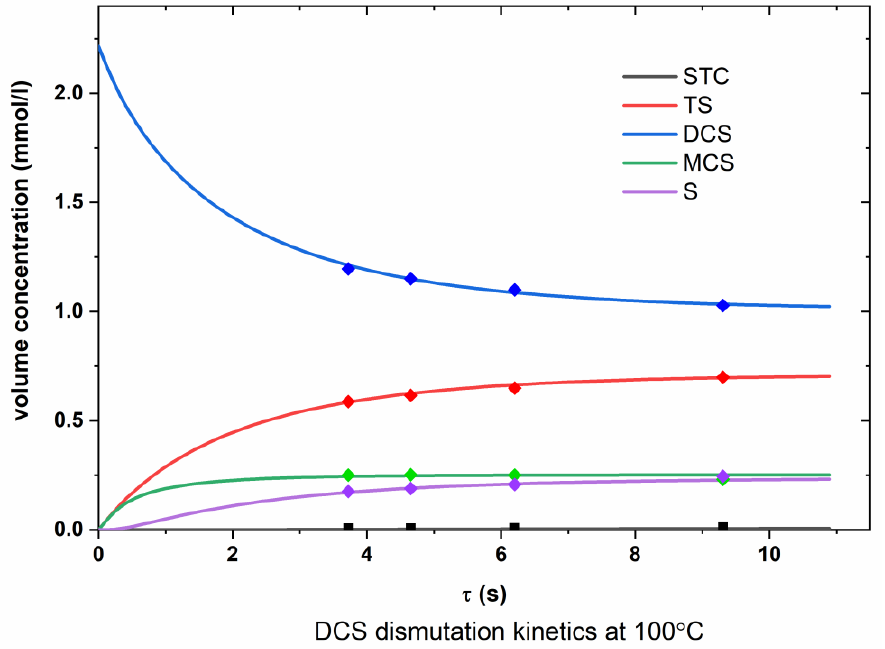
Figure A4. Dependence of the molar concentrations of chlorosilanes on time (DCS, 80 °C).